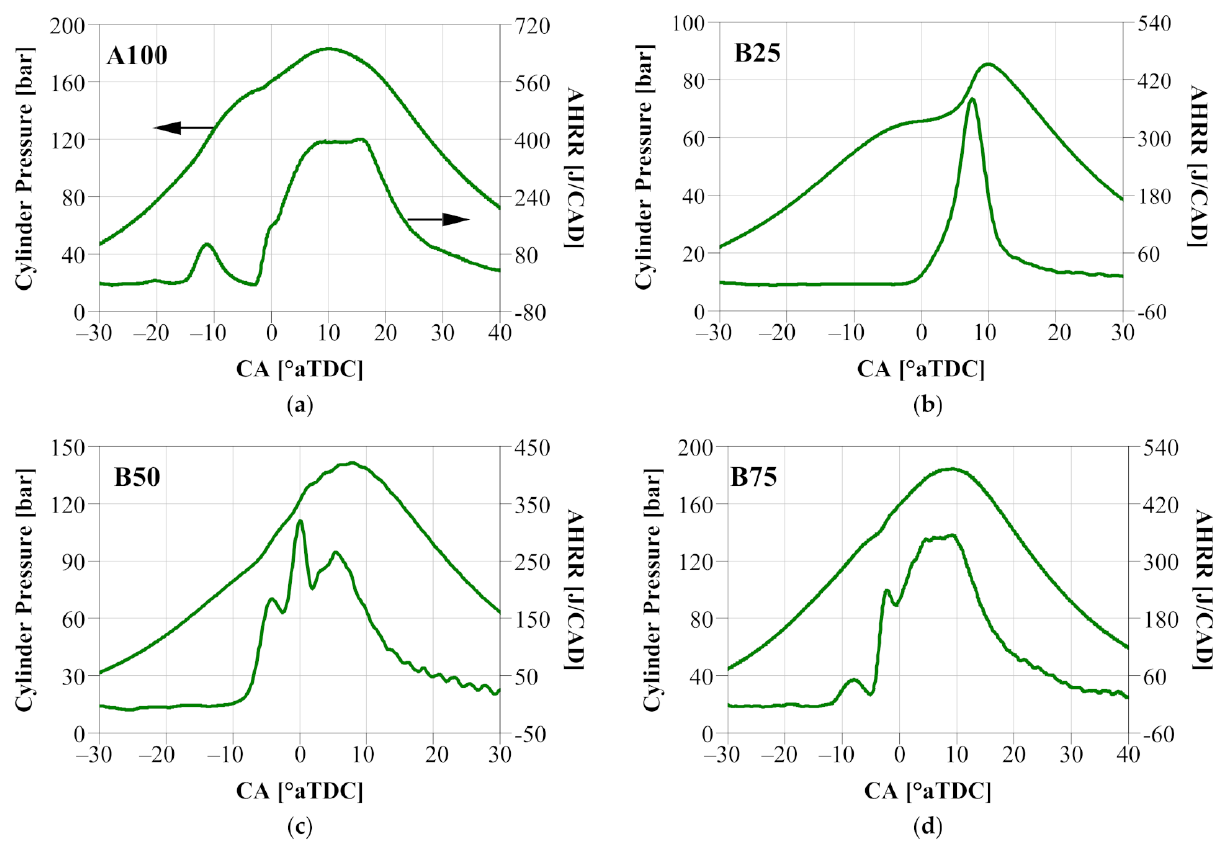
Figure 6. Cylinder pressure and AHRR for Gen1 GCI: ( a ) A100; ( b ) B25; ( c ) B50; ( d )